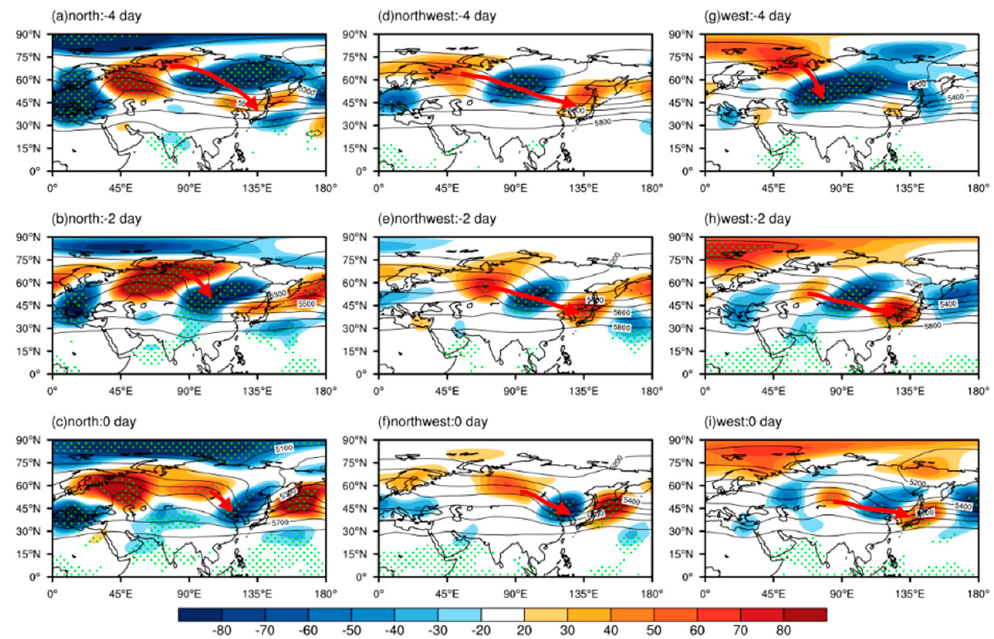
Figure 7. Composite of geopotential height (GPH) (contours; intervals of 100 m) and its anomalies (shaded areas; unit: m; significant values at the 0.05 confidence level are presented by green dots) at 500 hPa from day − 4 to day 0 relative to cold surge occurrences of the north ( a – c ), northwest ( d – f ), and west ( g – i ) types. Red arrows indicate the wave ‐ guided line.